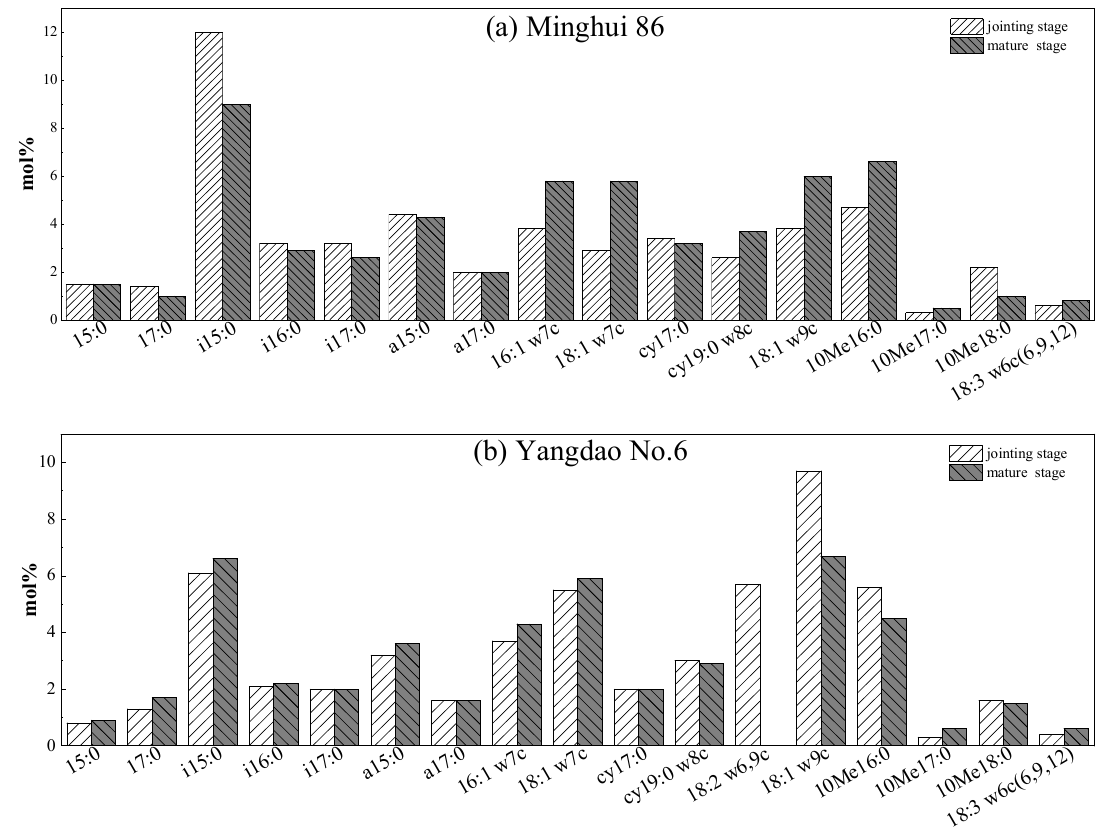
Figure 2. PLFA distribution of soil microorganisms in the tested soil; mol% represents the change in the mole fraction distribution of each characteristic fatty acid.